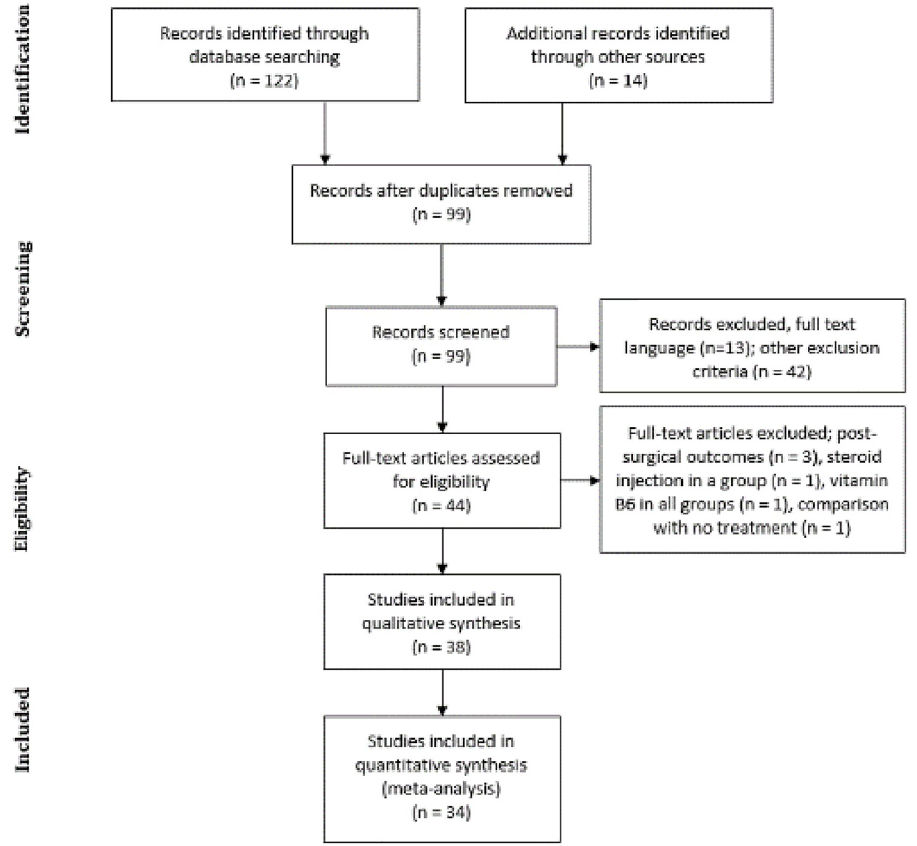
Fig 1. Flowchart of the study selection